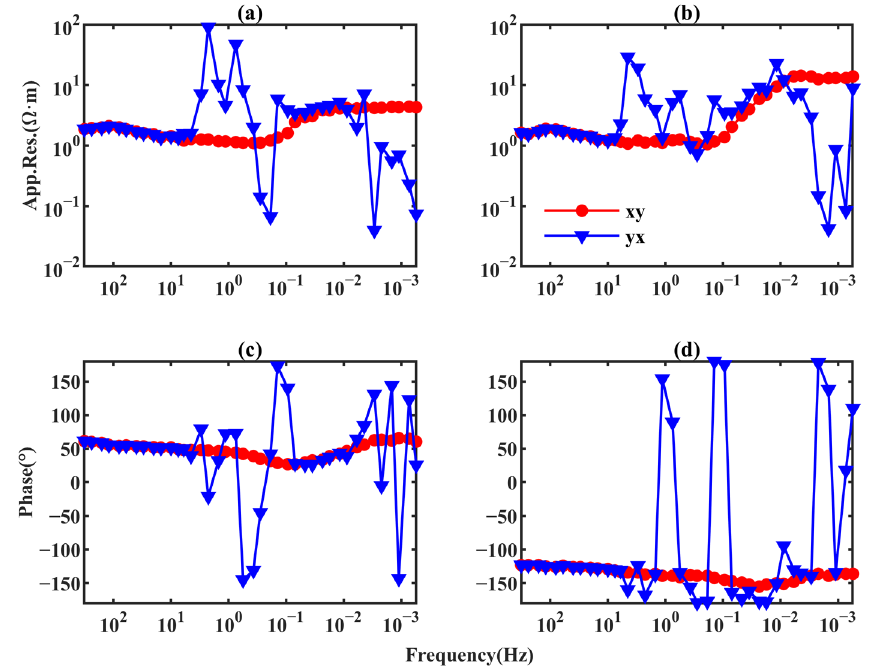
Figure 14. The apparent resistivity and phase of the 5th test dataset. ( a ) ρ xy , ( b ) ρ yx , ( c ) ϕ xy and ( d ) ϕ yx curves.